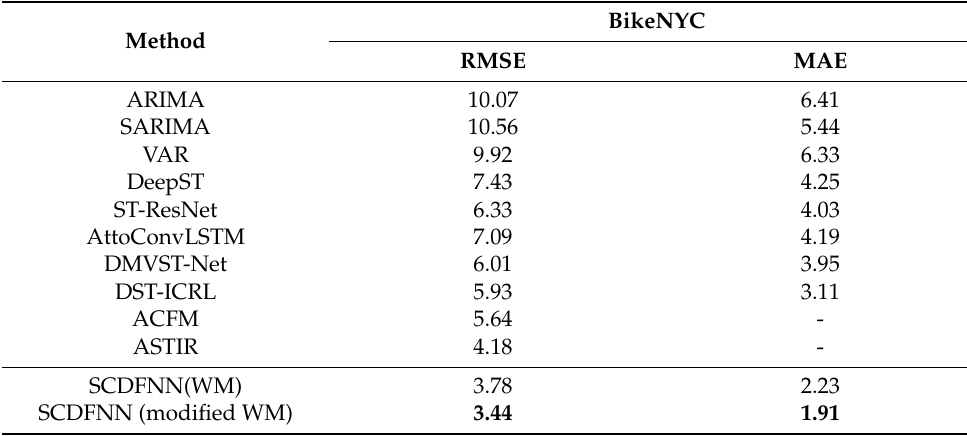
Table 5. Comparison results of different methods on BikeNYC